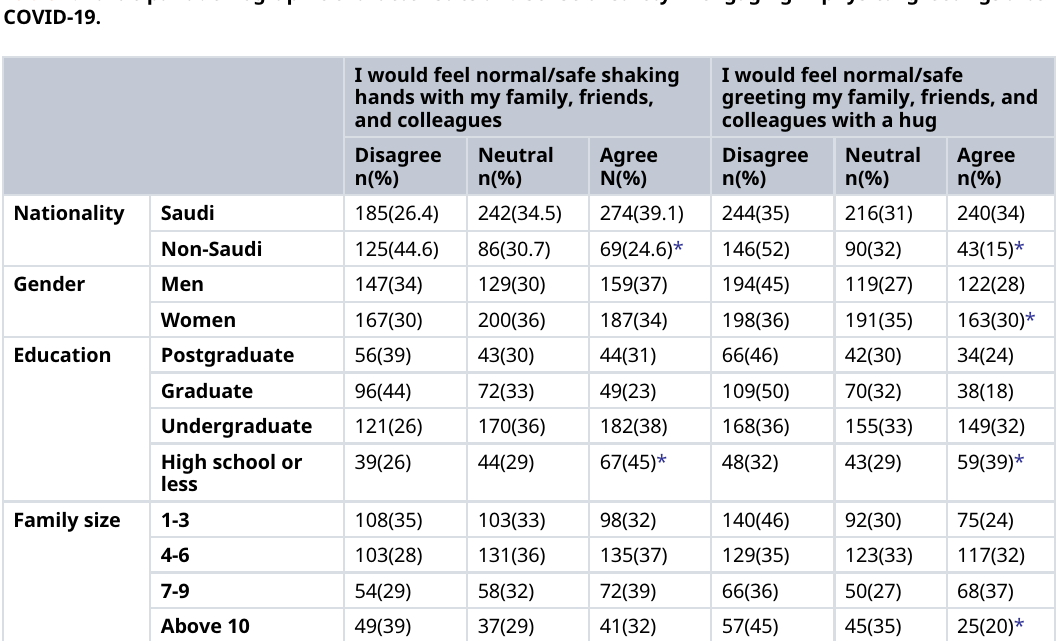
*Statistically significant at P <